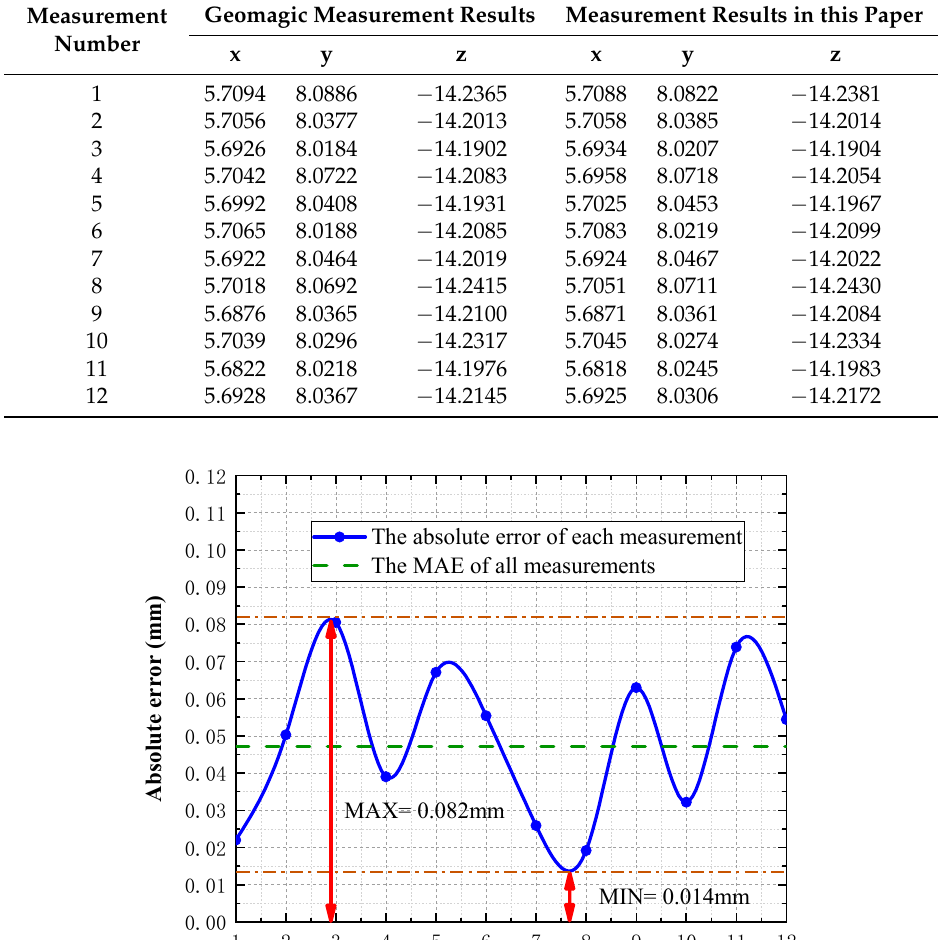
Table 5. The statistical results of the two methods.